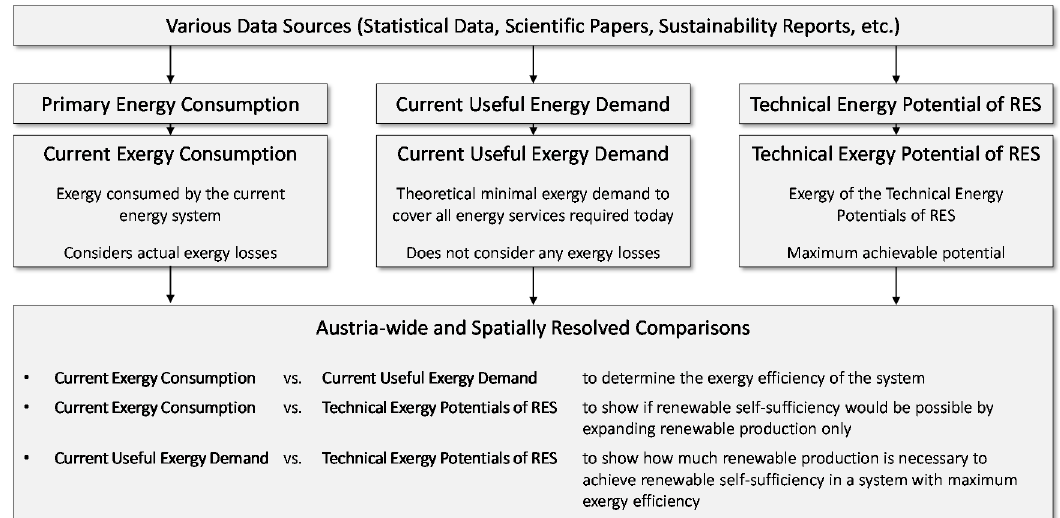
Figure 1. Schematic overview of the paper. First, the three exergy amounts—current exergy consumption, current useful exergy demand and technical exergy potential of renewable energy sources (RES)—are determined. Then, they are compared in a spatially resolved way, as well as on a country-wide level, to comprehensively analyze the situation in Austria.